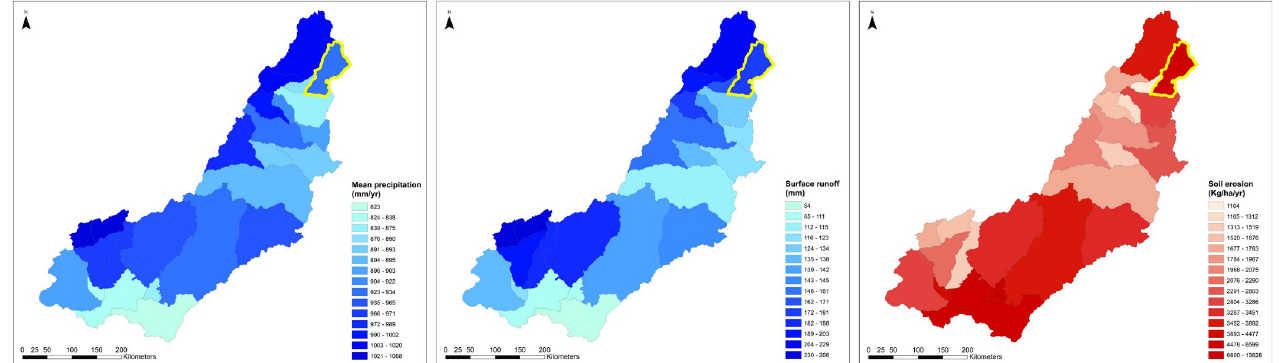
Fig 3. Geography of the study region: The piedmont zone. Annual precipitation (a) and surface runoff (b) for sub-basins. The Luwumbu catchment is highlighted in light blue. Mean precipitation, surface runoff and soil erosion reprinted under CC-BY 4.0 license from Hydroatlas Zambia v.1